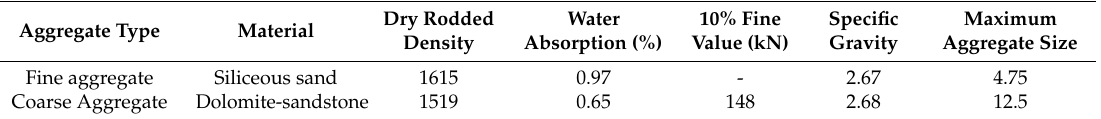
Table 1. Characteristics of aggregates.